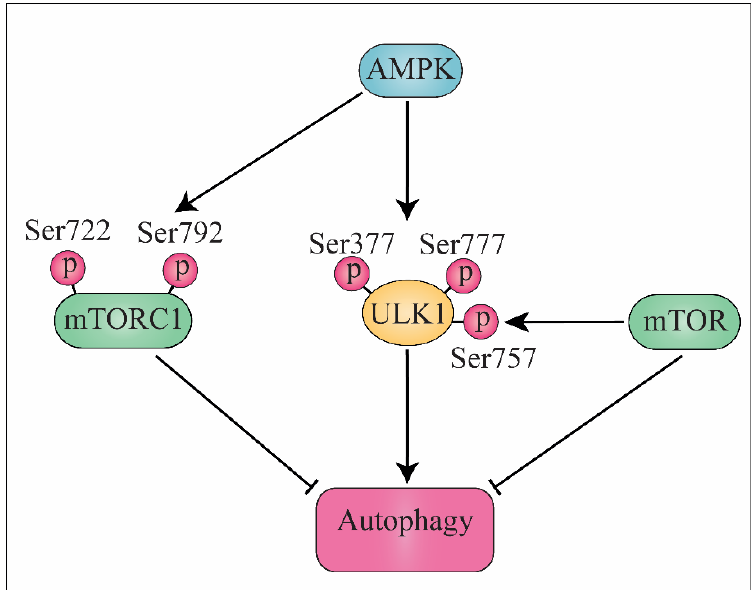
Figure 1. AMPK stimulates autophagy by phosphorylation of ULK1 at the Ser377 and Ser777. mTOR signaling pathway inhibits autophagy by phosphorylation of ULK1 at the Ser757. AMPK indirectly activates autophagy by suppressing mTORC1 via its phosphorylation at Ser722 and Ser792. AMPK, AMP-activated protein kinase; ULK1, unc-51 like autophagy activating kinase; mTOR, mechanistic target of rapamycin; mTORC1, mTOR complex 1.